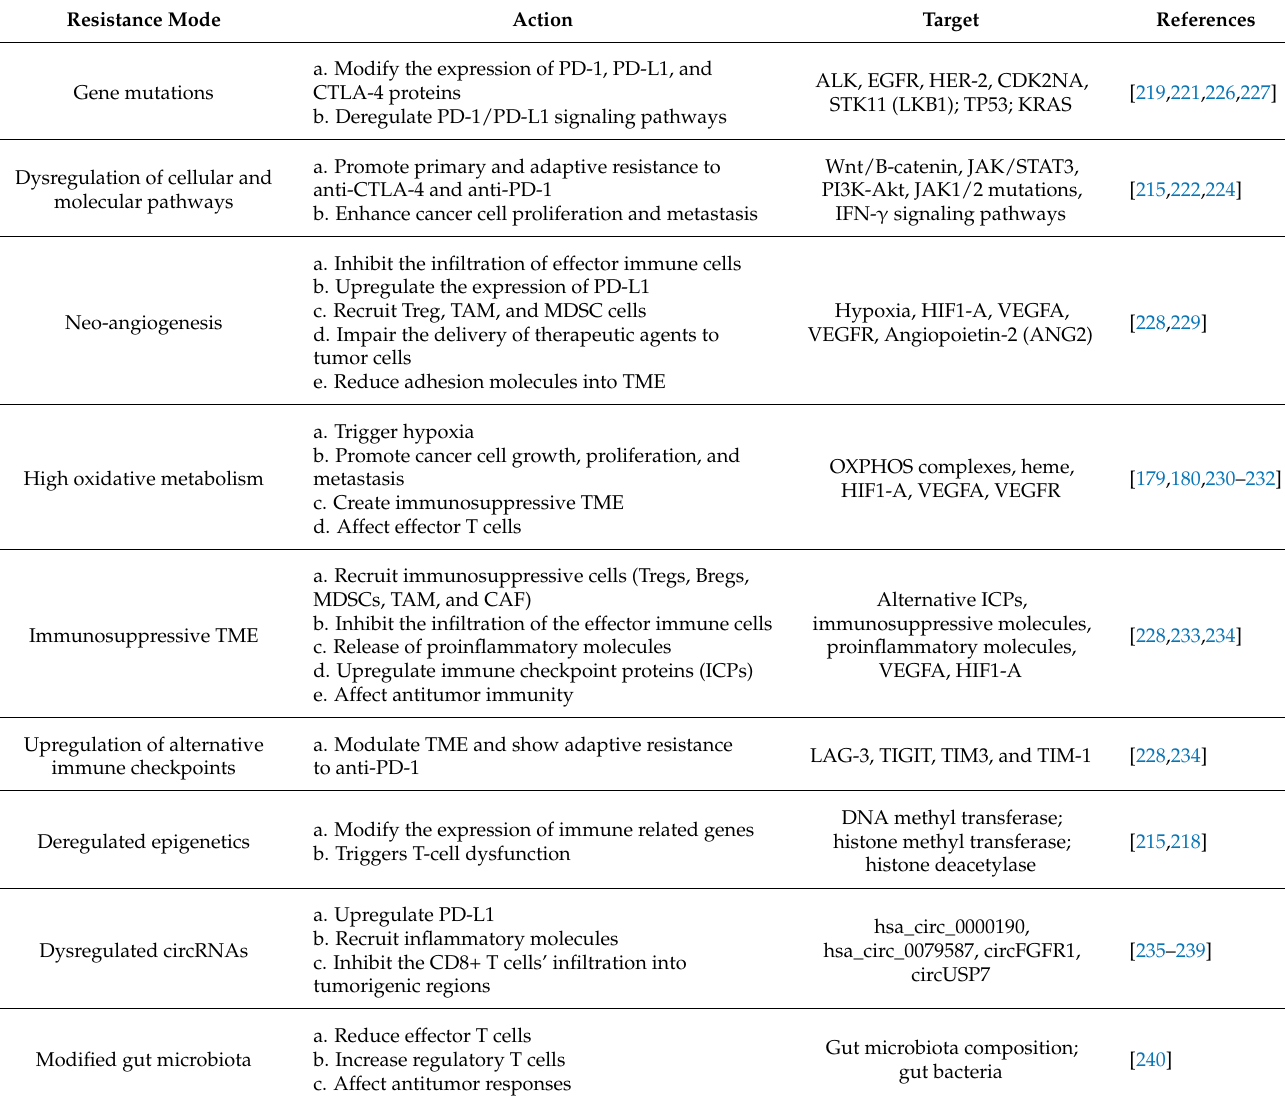
Table 2. Summary of mechanism of immunotherapeutic resistance and prospective targets in lung